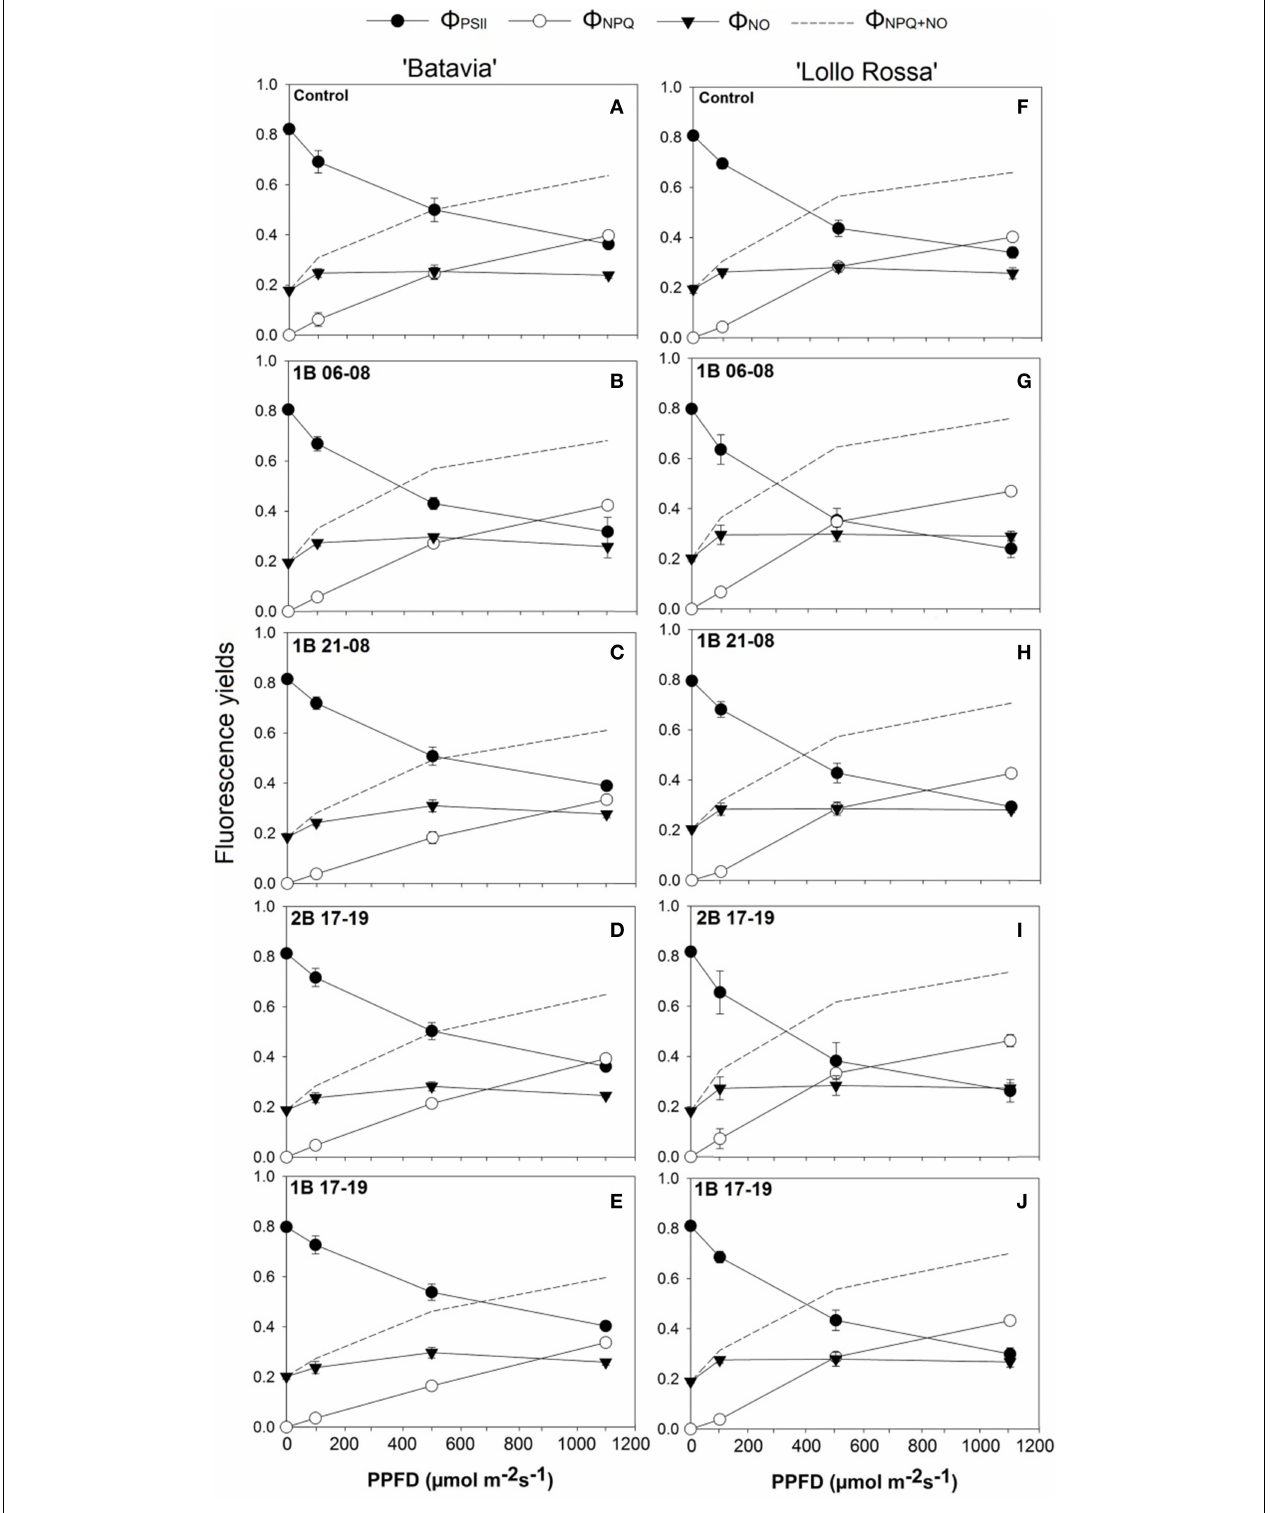
under the five different LED treatments with the same abbreviations as in Figure 2. Data are mean values ( n = 3, three different leaves from different plants per treatment and cultivar) ±